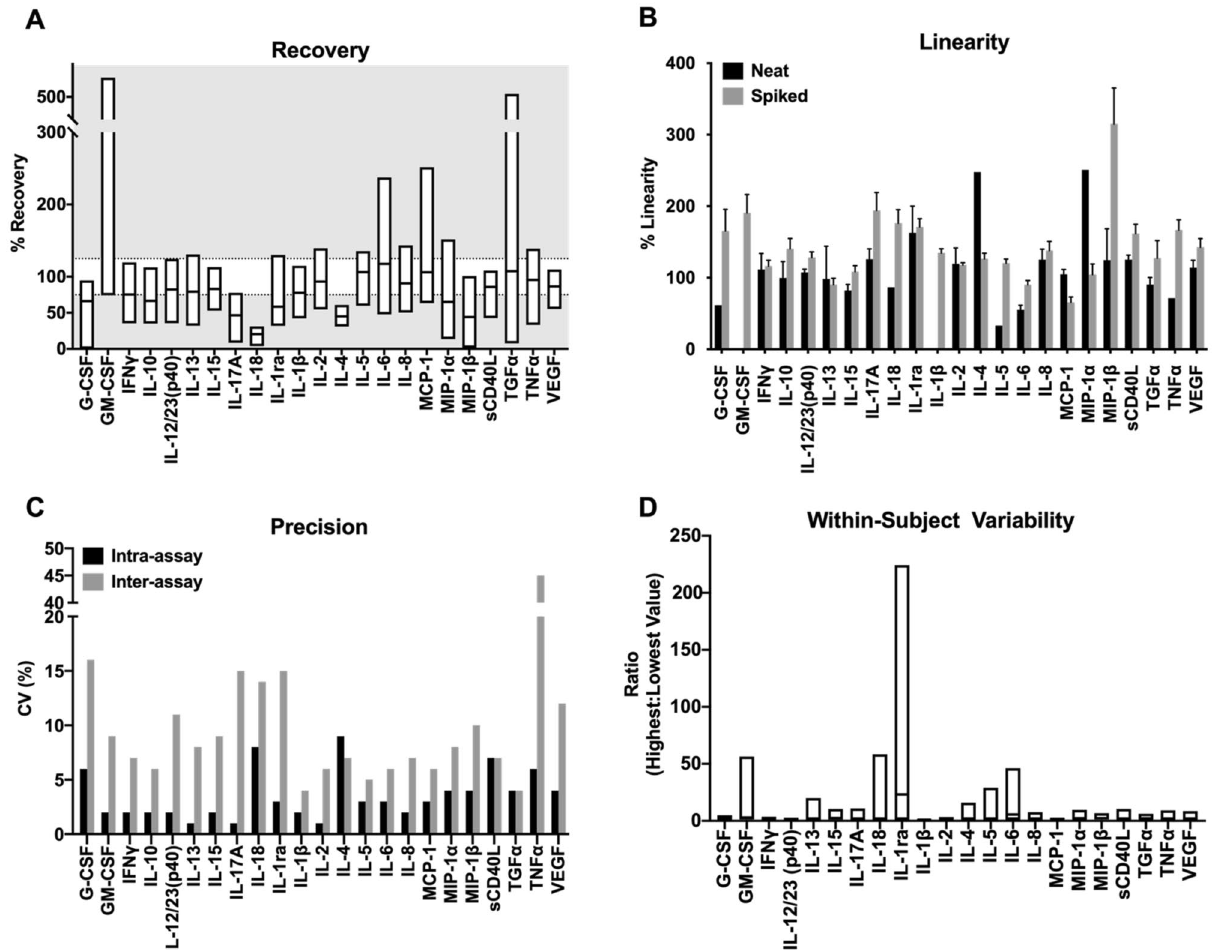
Figure 1. Validation study results. ( A ) Analyte recovery. NHP serum was spiked with a known amount of each cytokine. Recovery values between 75 and 125% were considered acceptable. ( B ) Linearity. NHP serum was tested neat as well as spiked with a known concentration of each cytokine. Linearity ranges between 75 and 125% were considered acceptable. ( C ) Precision. Intra-assay precision was measured between duplicate samples (n = 24). Inter-assay precision was measured across technical replicates (n = 4). ( D ) Within-Subject Variability. Variability was measured by calculating the variability in cytokine measurements between samples taken from the same